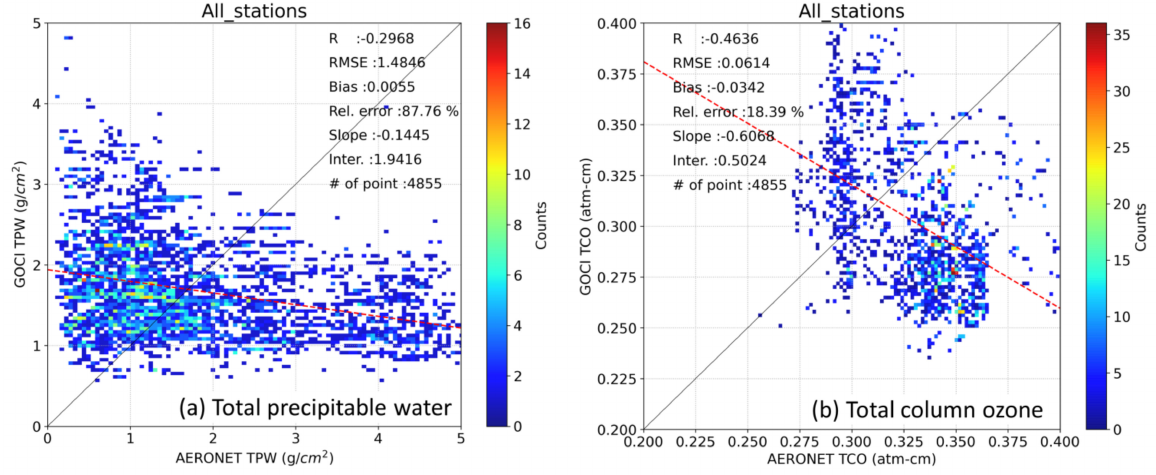
Figure 7. Density scatterplots of CAMS data versus AERONET measurements: ( a ) TPW and ( b ) TCO. The color bar of each figure denotes the data counts in 0.05 × 0.05 and 0.004 × 0.04,